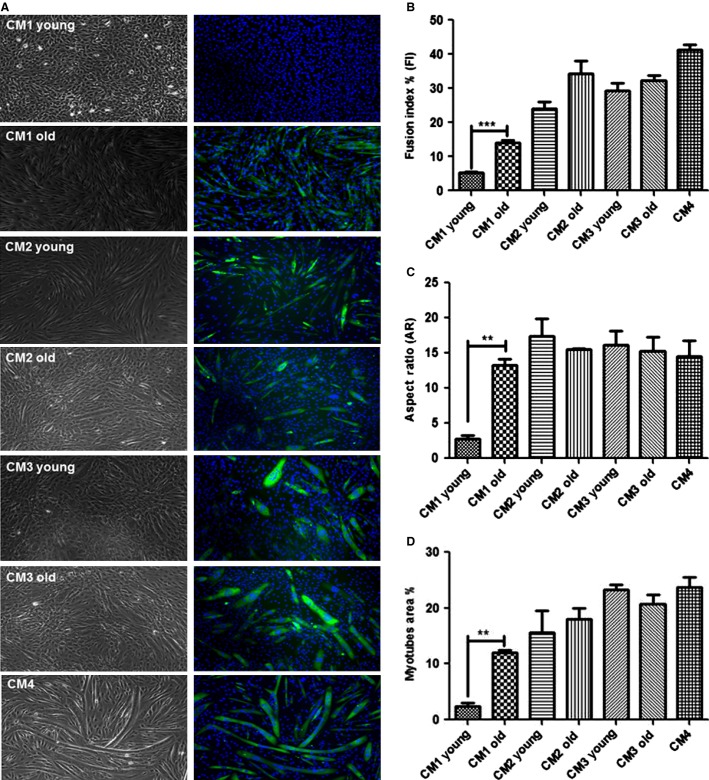
Brightfield (right panel) and Immunofluorescence analysis of skeletal myosin heavy chain (left panel), the typical marker of terminally differentiated muscle cells. Morphometric parameters for myotubes development Myoblast fusion of C2C12 cells following 4 days incubation with CM young and old. C2C12 cell cultures stained immunofluorescence of a high-affinity MHC (marker of differentiation) -heavy-chain Alexa Fluor-488-MyHC (green) and DAPI (blue) nuclear counterstain. All negative controls develop myoblasts fusion into myotubes following 4 days of incubation. Images were taken from random fields by Leica DMI6000B microscope at ×10 magnification. **P < 0.001; ***P < 0.0001.